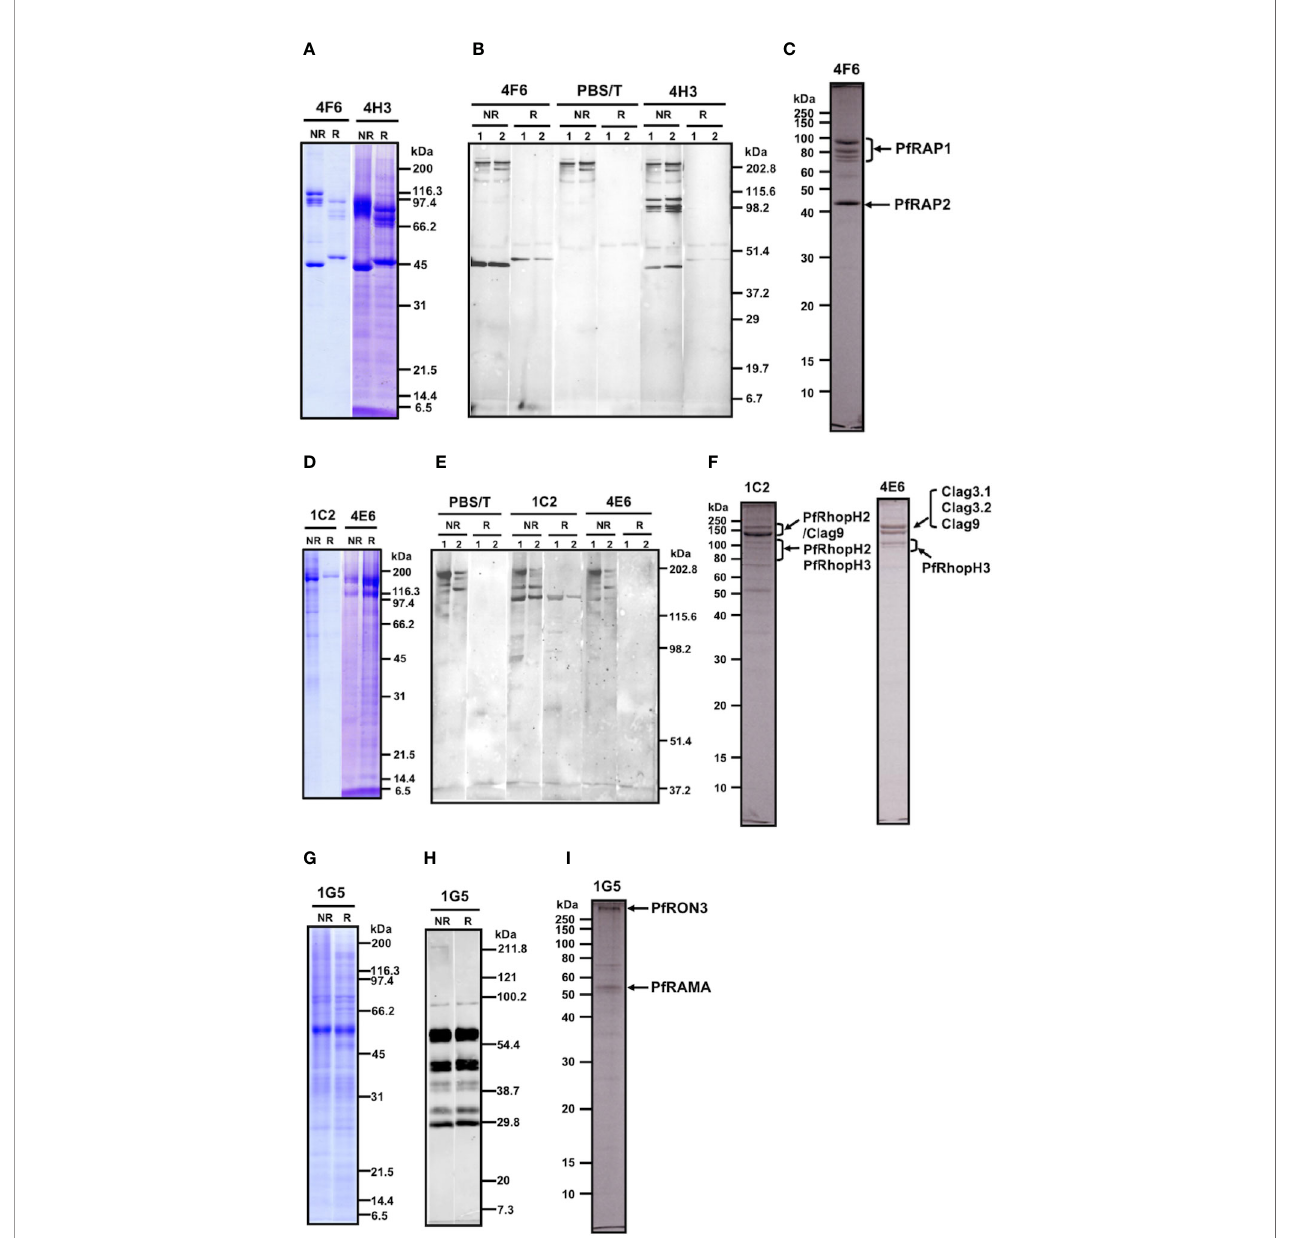
FIGURE 2 | (A – C) Analyses of the immunoaf fi nity-puri fi ed proteins using af fi nity columns conjugated with either mAb 4F6 or 4H3. (A) The elution fractions were resolved by 12.5% SDS-PAGE under reducing or non-reducing conditions. (B) Western blot analyses of elution fractions. Elution fractions from 4F6 (lane 1) and 4H3 (lane 2) af fi nity columns were resolved by 12.5% SDS-PAGE and the proteins were probed with either mAb 4F6 or 4H3. PBS/T serves as a negative control staining. (C) Protein bands used for the LC-MS/MS analyses. The elution fraction from the 4F6 column was resolved by 10% SDS-PAGE under reducing conditions and the target bands (arrows) were excised from the gel. Proteins identi fi ed by LC-MS/MS are indicated. (D – F) Analyses of the immunoaf fi nity-puri fi ed proteins using af fi nity columns conjugated with either mAb 1C2 or 4E6. (D) The elution fractions were resolved by 12.5% SDS-PAGE under reducing or non-reducing conditions. (E) Western blot analyses of elution fractions. The elution fractions from the 1C2 (lane 1) and 4E6 (lane 2) af fi nity columns were resolved by 7.5% SDS-PAGE and the proteins were probed with either mAb 1C2 or 4E6. PBS/T serves as a negative control staining. (F) Protein bands used for the LC-MS/MS analyses. The elution fractions from the 1C2 and 4E6 columns were resolved by 10% SDS-PAGE under reducing conditions and the target bands (arrows) were excised from the gel. Proteins identi fi ed by LC-MS/MS are indicated. (G – I) . Analyses of the immunoaf fi nity-puri fi ed proteins using an af fi nity column conjugated with mAb 1G5. (G) The elution fraction was resolved by 12.5% SDS-PAGE under reducing or non-reducing conditions. (H) Western blot analysis of elution fraction. Elution fractions from the 1G5 af fi nity column were resolved by 12.5% SDS-PAGE and the proteins were probed with mAb 1G5. (I) Protein bands used for the LC-MS/MS analyses. The elution fraction from the 1G5 column was resolved by 10% SDS-PAGE under reducing conditions and the target bands (arrows) were excised from the gel. Proteins identi fi ed by LC-MS/MS are